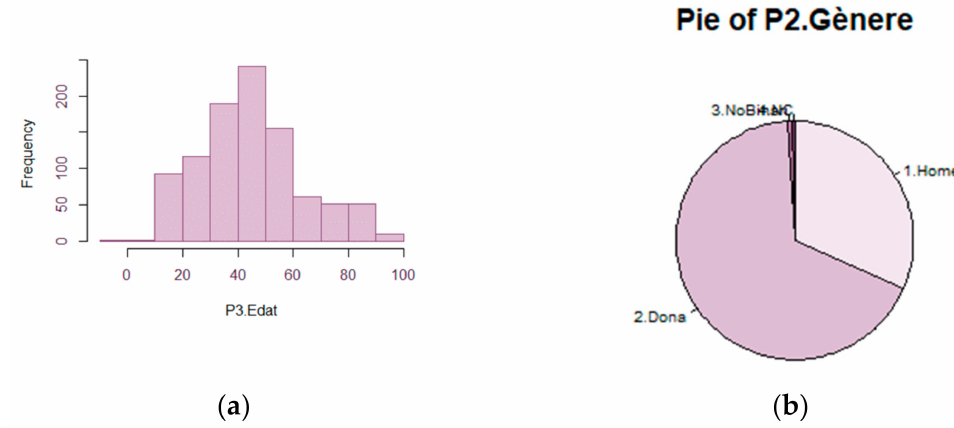
Figure 20. ( a ) Histogram of Edat; ( b ) Pie chart of Gender.